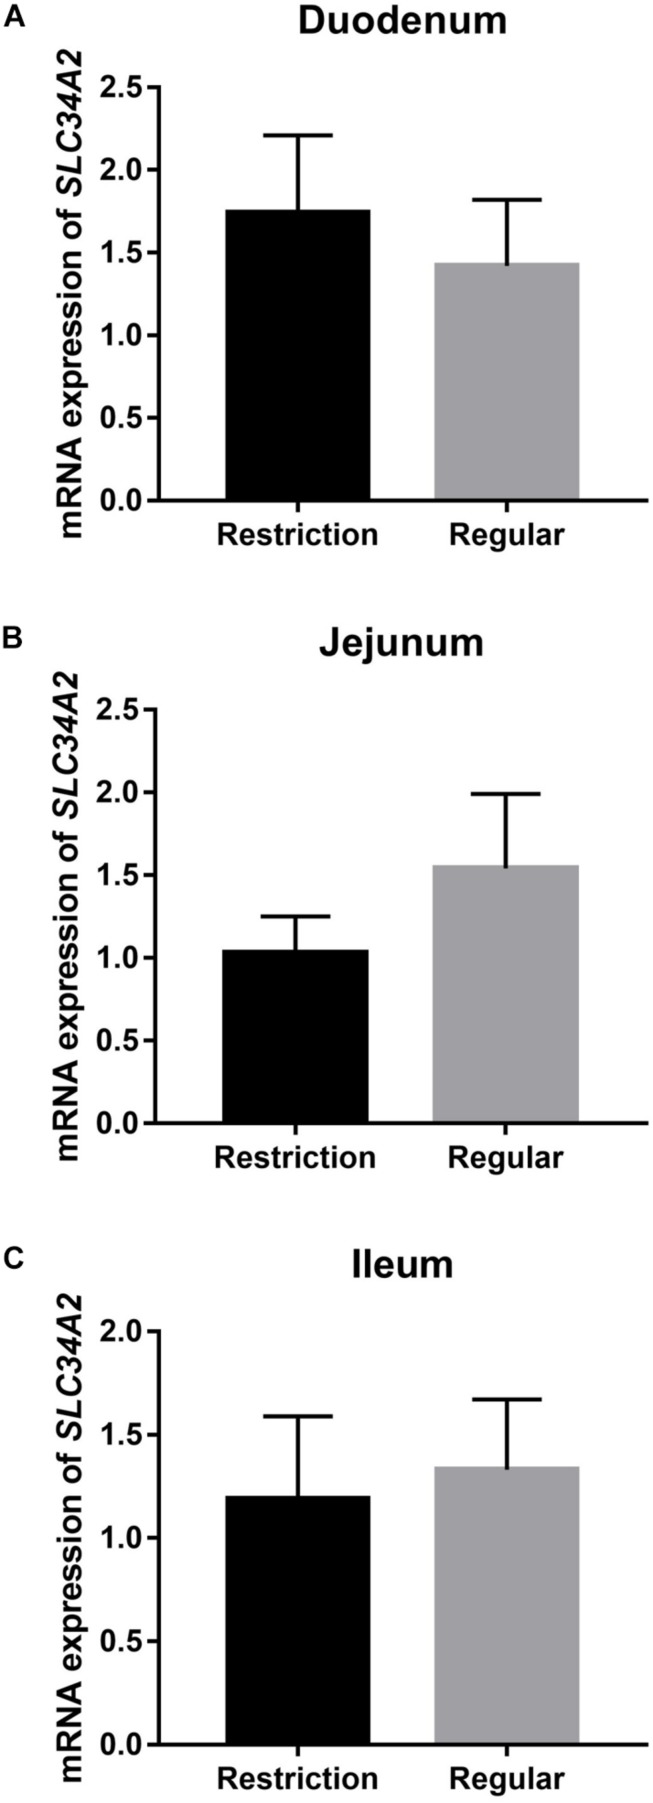
Effects of dietary non-phytate phosphorus levels (restriction, 0.14%; regular, 0.32%) on intestine (A) duodenum, (B) jejunum, and (C) ileum mRNA expressions of SLC34A2 in laying hens. SLC34A2 is the gene coding for type 2b sodium-phosphorus co-transporter (NPt2b). Values are of 7 hens/treatment. Experiment 2.